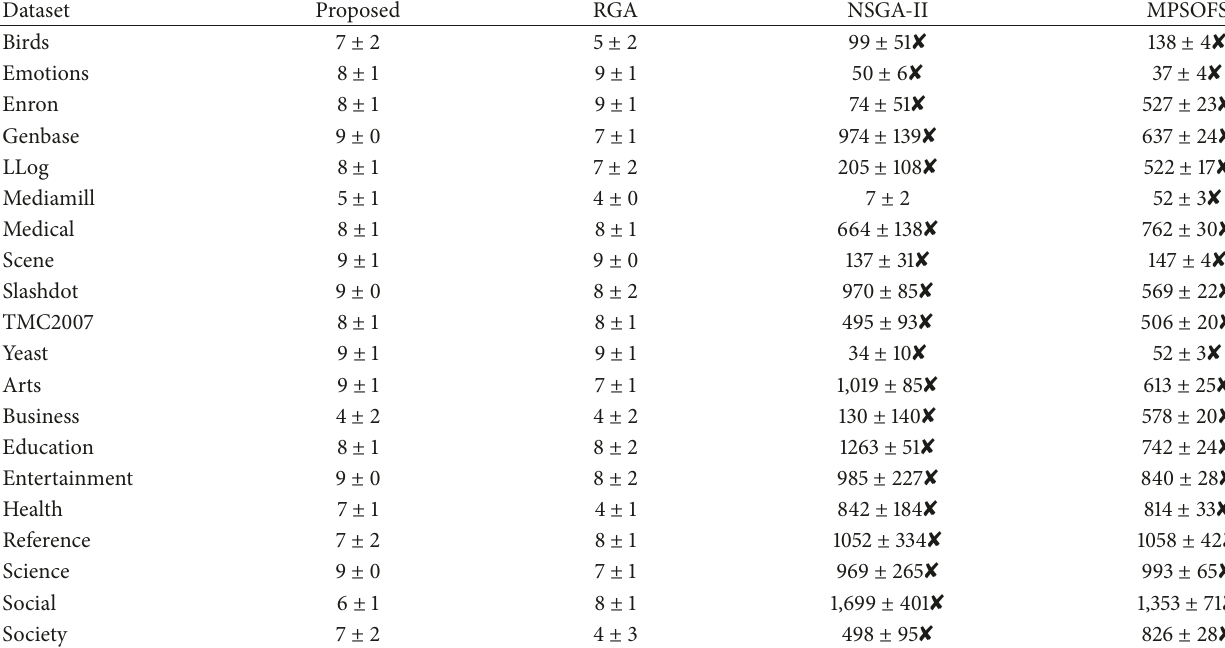
Table 2: Comparison results for multilabel feature selection methods in terms of selected feature subset size (mean ± std. deviation). The N symbol is used to indicate that the corresponding method failed to select less than 10 features for the